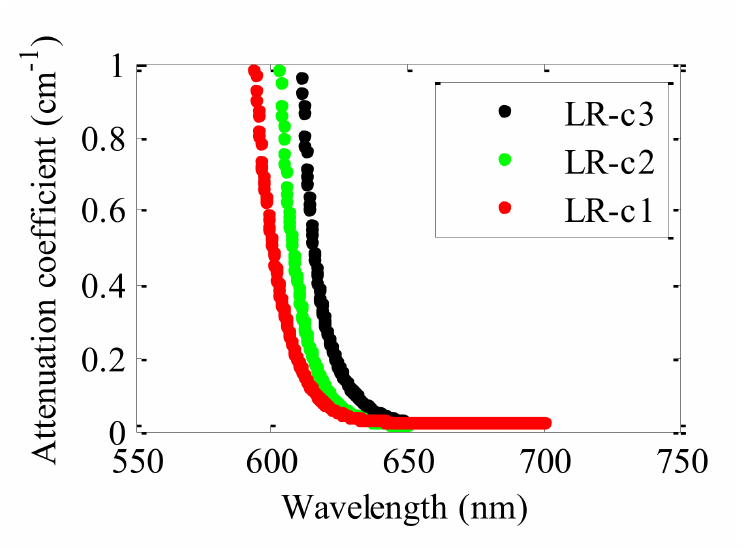
Figure 7. Attenuation coefficients for three lumogen red doped fibers manufactured using the casting method. The excitation irradiance was 22 nJ · cm − 2 at 520 nm with z e = 1.2